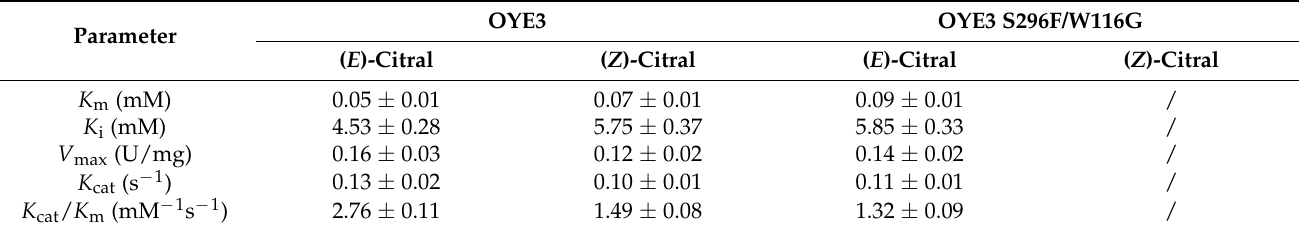
Table 4. Apparent kinetic parameters of OYE3 and its variant S296F/W116G 1 .